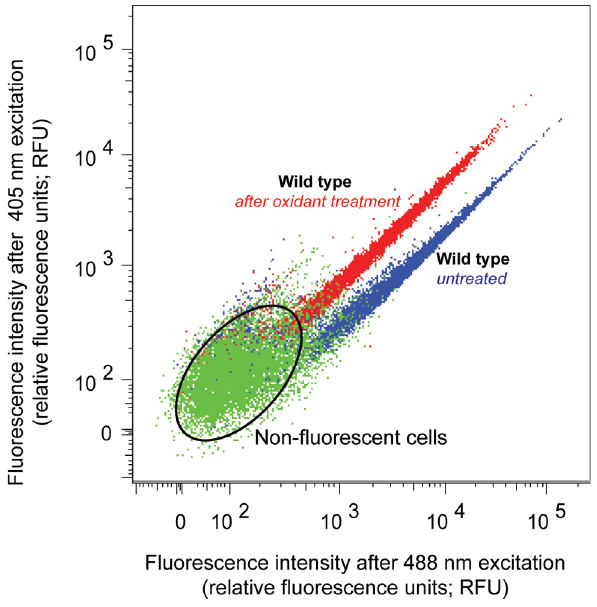
Figure 1. Representative dot plot of cells expressing cytosolic roGFP2. Cells expressing cytosolic roGFP2 were grown to exponential phase (A 600 , 0.5) in SC URA and analyzed by flow cytometry. Dot plot of wild-type cells untreated and treated with oxidant (4 mM hydrogen peroxide). Note the shift in the populations after treatment with hydrogen peroxide towards 405 nm. Dot plots were generated using FlowJo TM software.